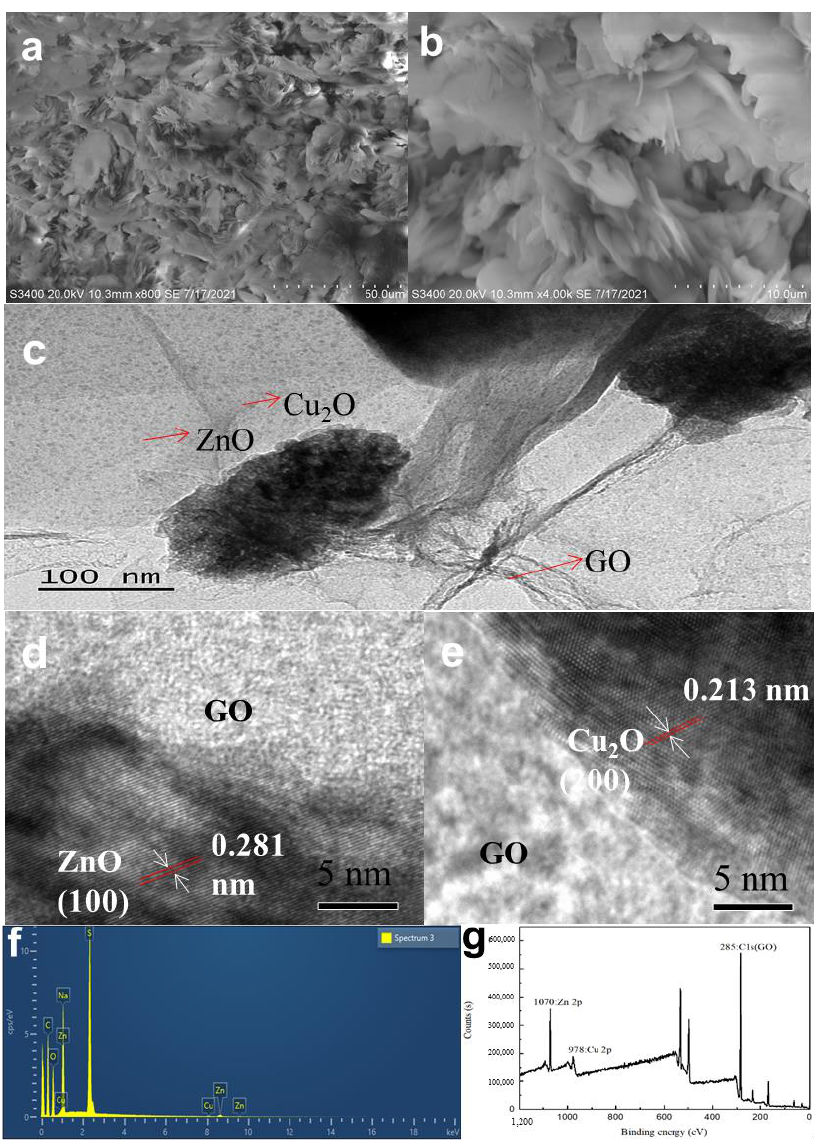
Figure 2. ( a,b ) SEM pictures. ( c – e ) HRTEM image. ( f ) EDS spectra. ( g ) XPS spectra of GZC anti- bacterial powder. antibacterial